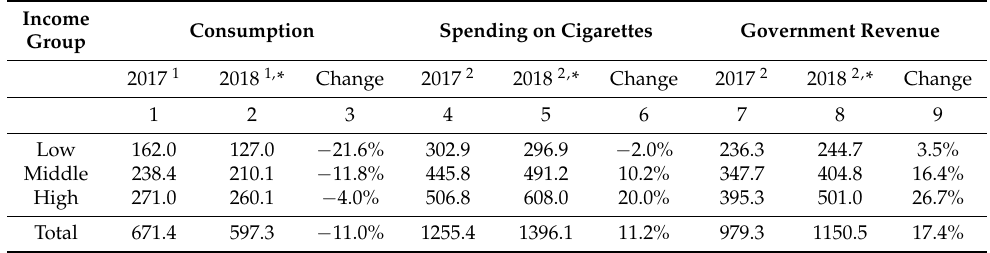
Table 3. Impact of price increase on consumption and expenditures by income